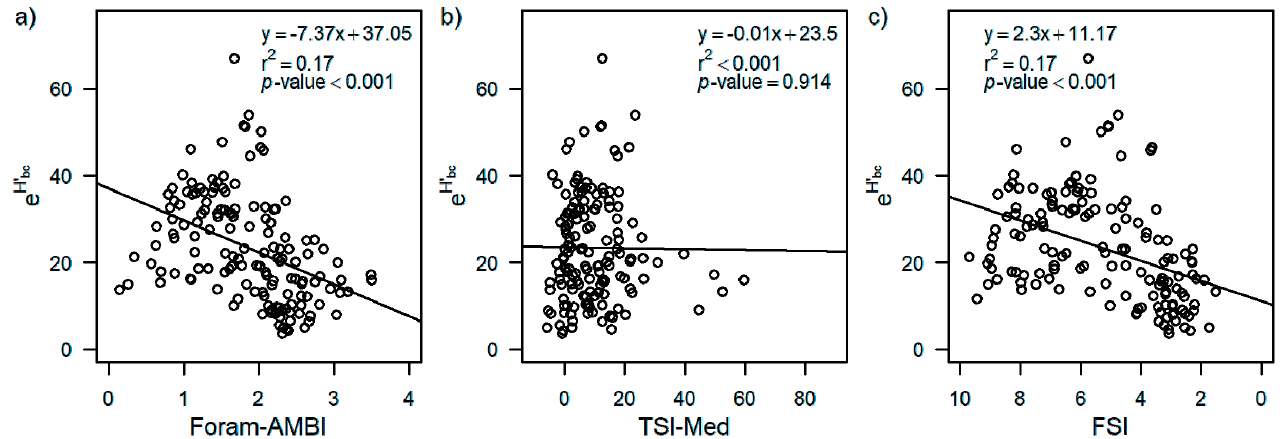
Figure 2. Values of the effective number of species (exp(H’ bc )) compared to the values of the ( a ) Foram-AMBI, ( b ) TSI-Med, and ( c ) FSI for the 125–500 µm size fraction. The scale for FSI is reversed so that the environmental quality scale increases to the right for each index.